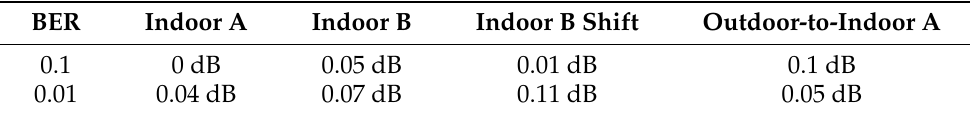
Table 6. SNR gap between G and R methods ( SNR G − SNR R ) for the particular BERs and channel models with a resolution 0.01